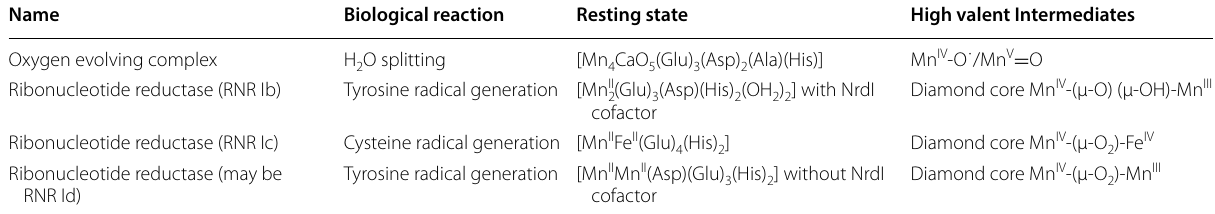
Table 1 High-valent Mn-oxo intermediates involved in OEC and RNR Name Biological reaction Resting